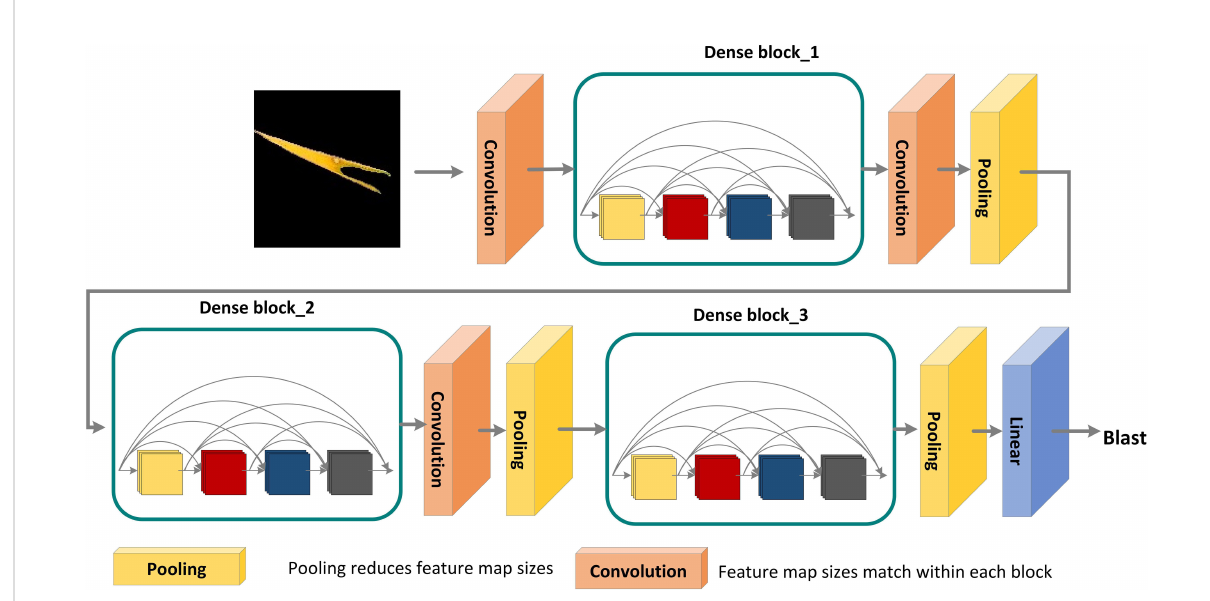
FIGURE 8 DenseNet pre-training model for disease areas classi fi cation. A deep DenseNet with three dense blocks. The layers between two adjacent blocks are referred to as transition layers and change feature-map sizes via convolution and